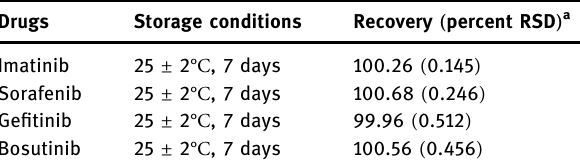
Table 3: Solution stability data of imatinib, sorafenib, ge fi tinib and bosutinib analyzed by the proposed conductometric method using medium quality control solutions